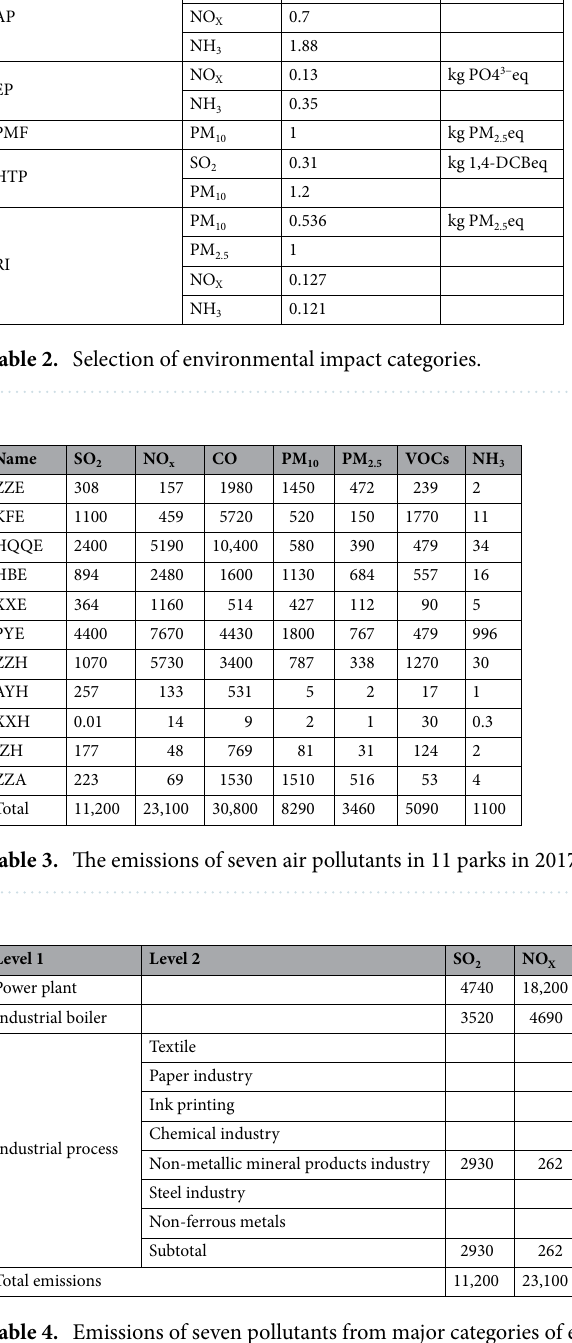
Table 4. Emissions of seven pollutants from major categories of emission sources in parks. (Unit: